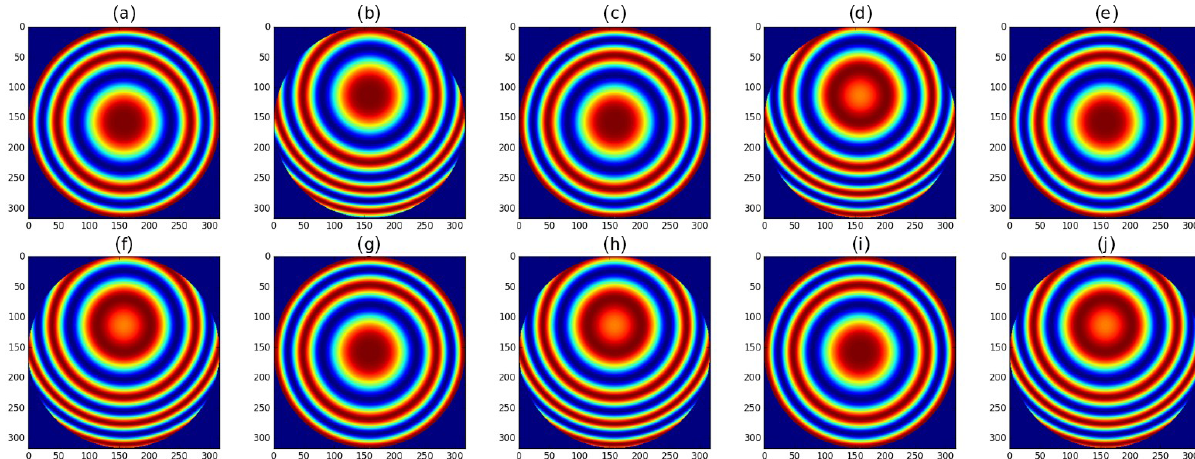
Figure 2. The Haidinger fringes at maximum OPD for misalignment a to j shown in Fig. 1.